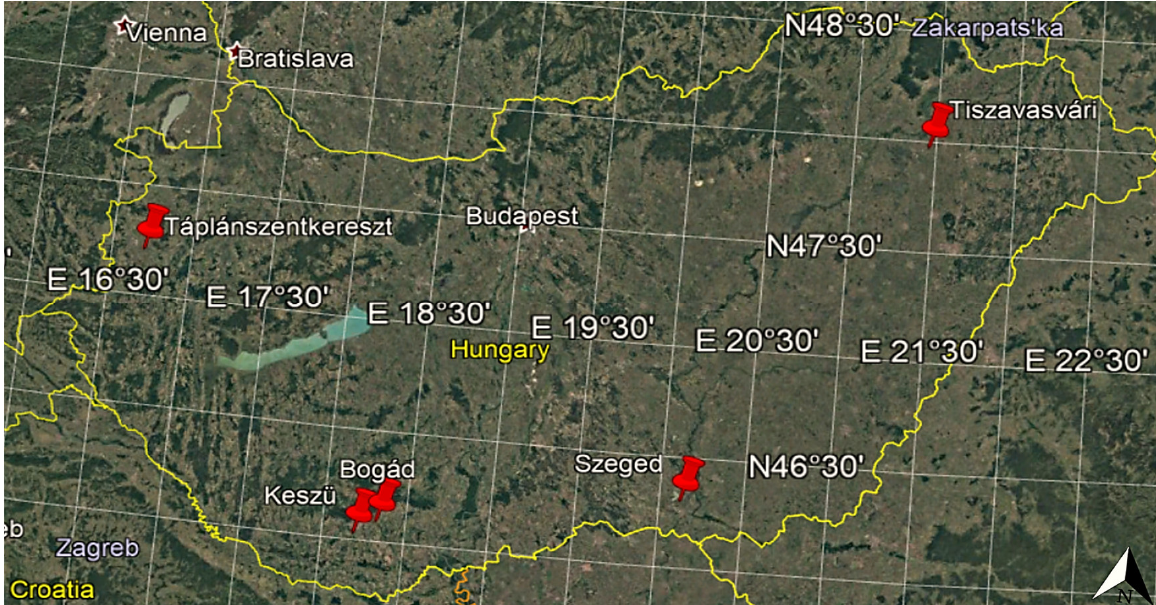
Figure 1. The locations selected for the examination of the shading effects of high-voltage transmission towers and their conductors (sites indicated by the red markers), based on [41].